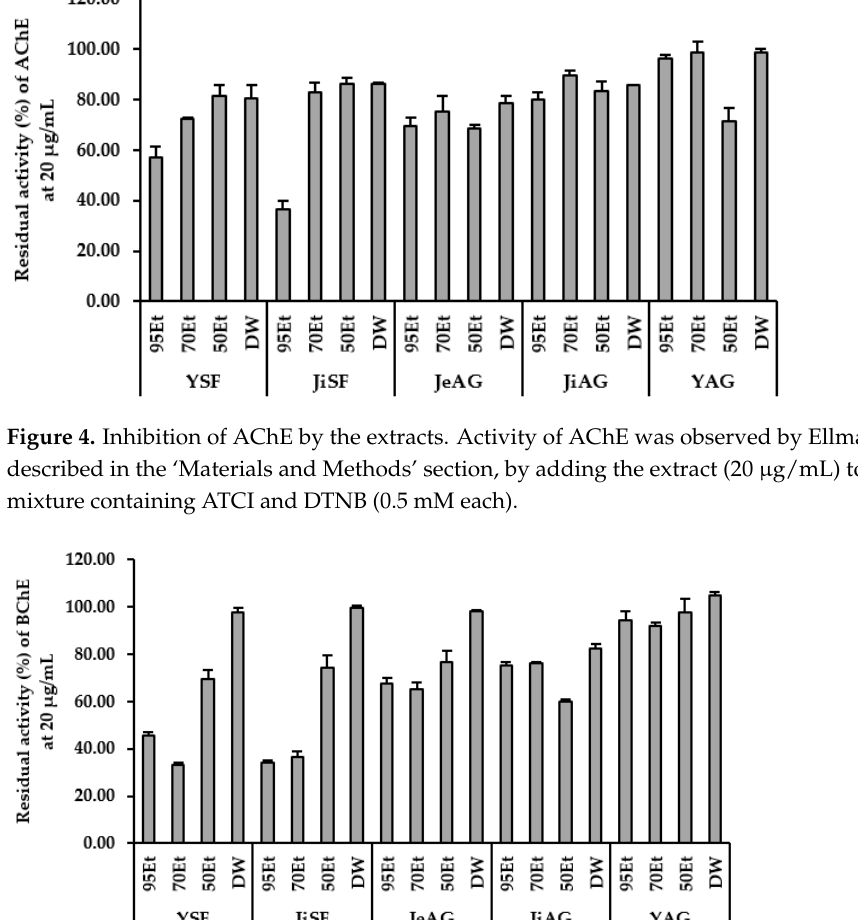
Figure 5. Inhibition of BChE by the extracts. Activity of BChE was observed by Ellman method as described in the ‘Materials and Methods’ section, by adding the extract ( 20 μg/mL ) to the reaction mixture containing BTCI and DTNB (0.5 mM each).